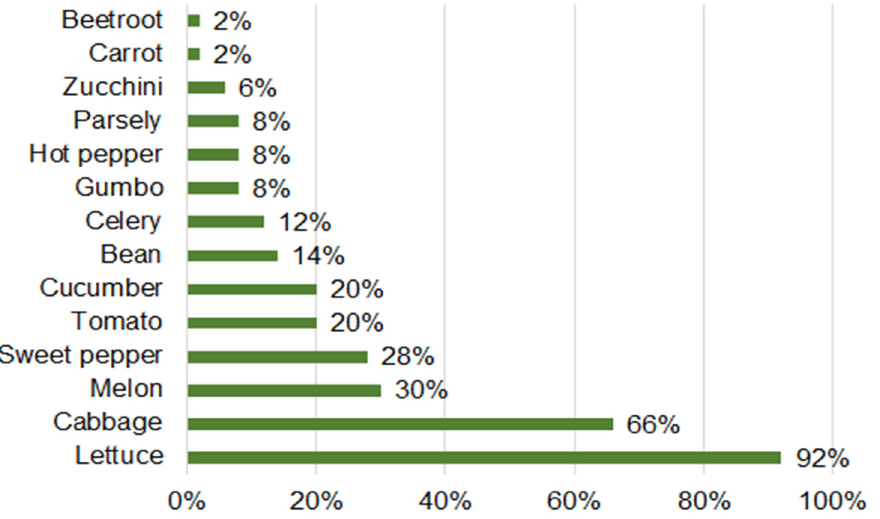
Figure 3. An example of different crops production in the suburb of Niamey (Data from [37]).